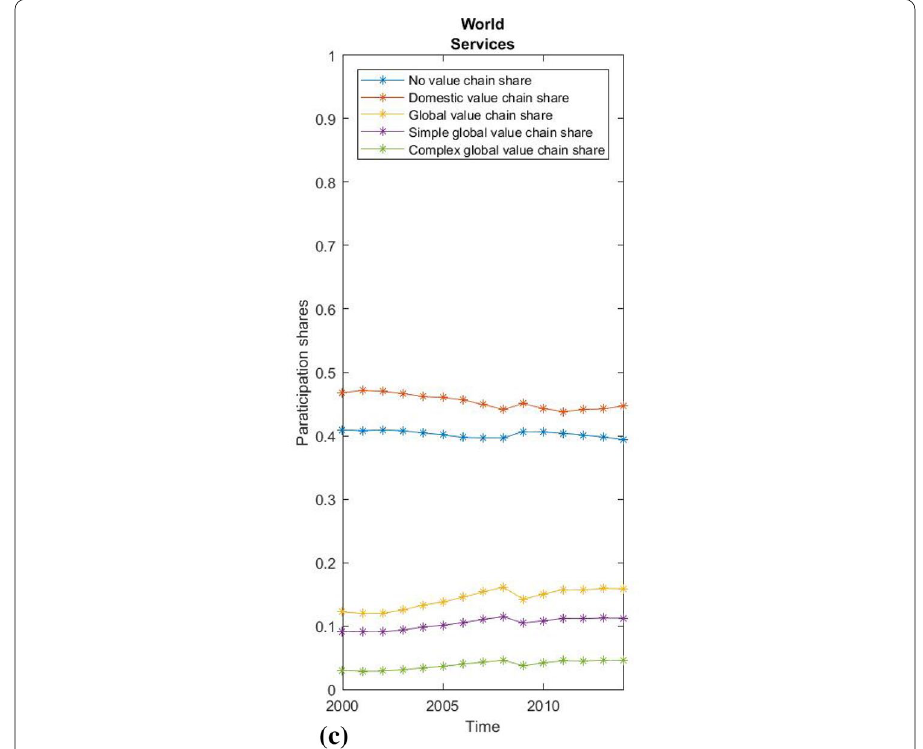
Fig. 4 World average of services. Source: WIOD 2016; own